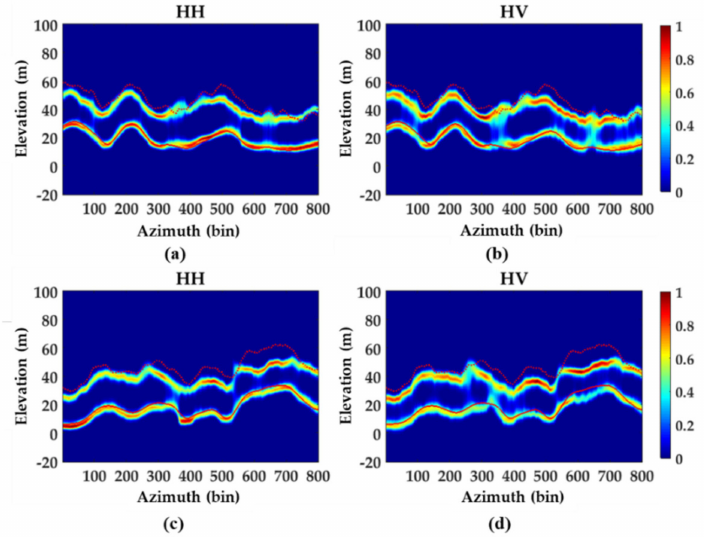
Figure 4. The normalized tomograms of two test lines estimated by the IMLE method for two different polarimetric channels: ( a ) HH channel tomogram of test line1; ( b ) HV channel tomogram of test line1; ( c ) HH channel tomogram of test line2; ( d ) HV channel tomogram of test line2. The red dotted and solid lines represent DTM + CHM and DTM,